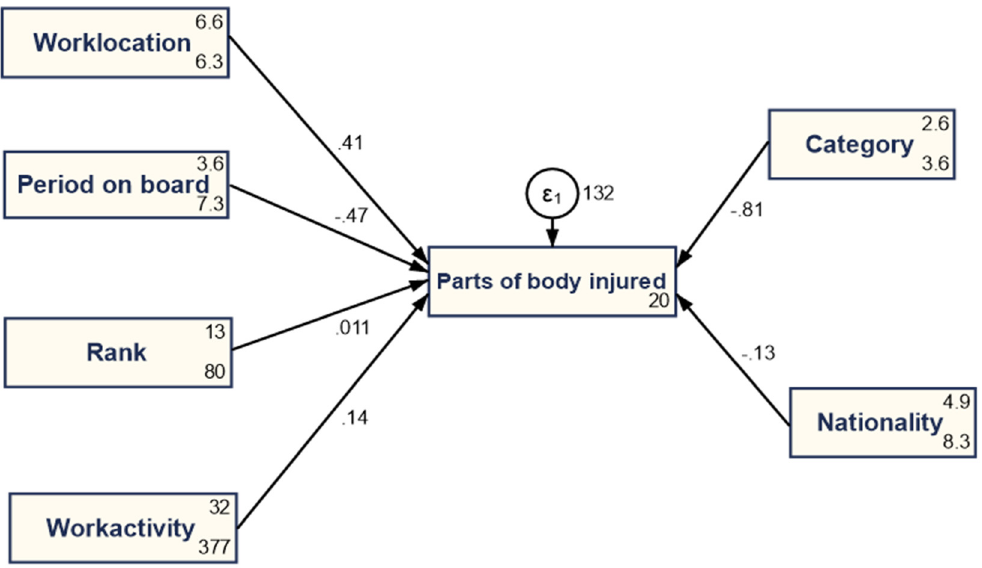
Figure 6. SEM 2, second model of structural equation modeling. Source: Own data process in Stata.